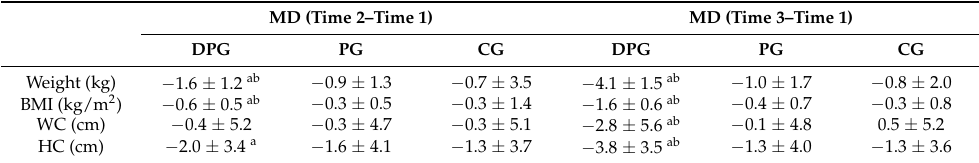
Table 3. Changes in weight outcomes at Time 1 and Time 2 compared to baseline for all participants ( n =